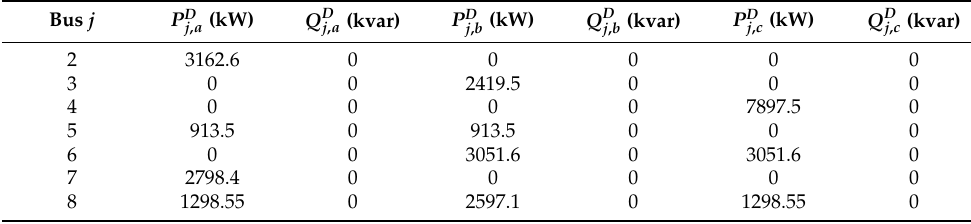
Table 6. Load for each phase in the 8-bus test system for the unbalanced case.